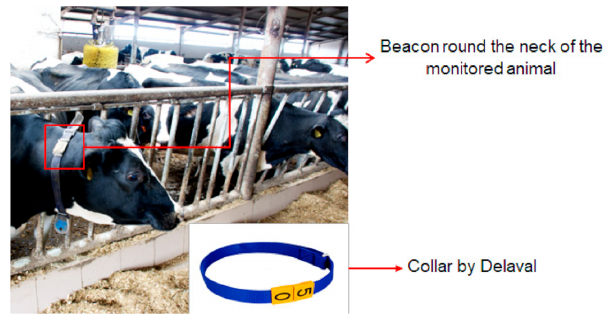
Figure 2. Beacon round the neck of the monitored animal.